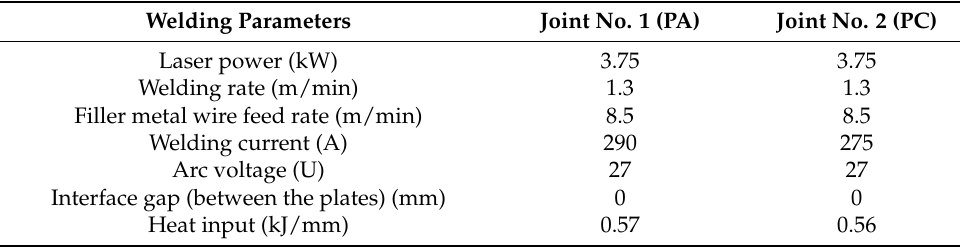
Table 2. Parameters of the hybrid-welding process used when making the joints (having thicknesses of 5 mm and 7 mm) in the flat position (joint no. 1 PA) and horizontal position (joint no. 2 PC).